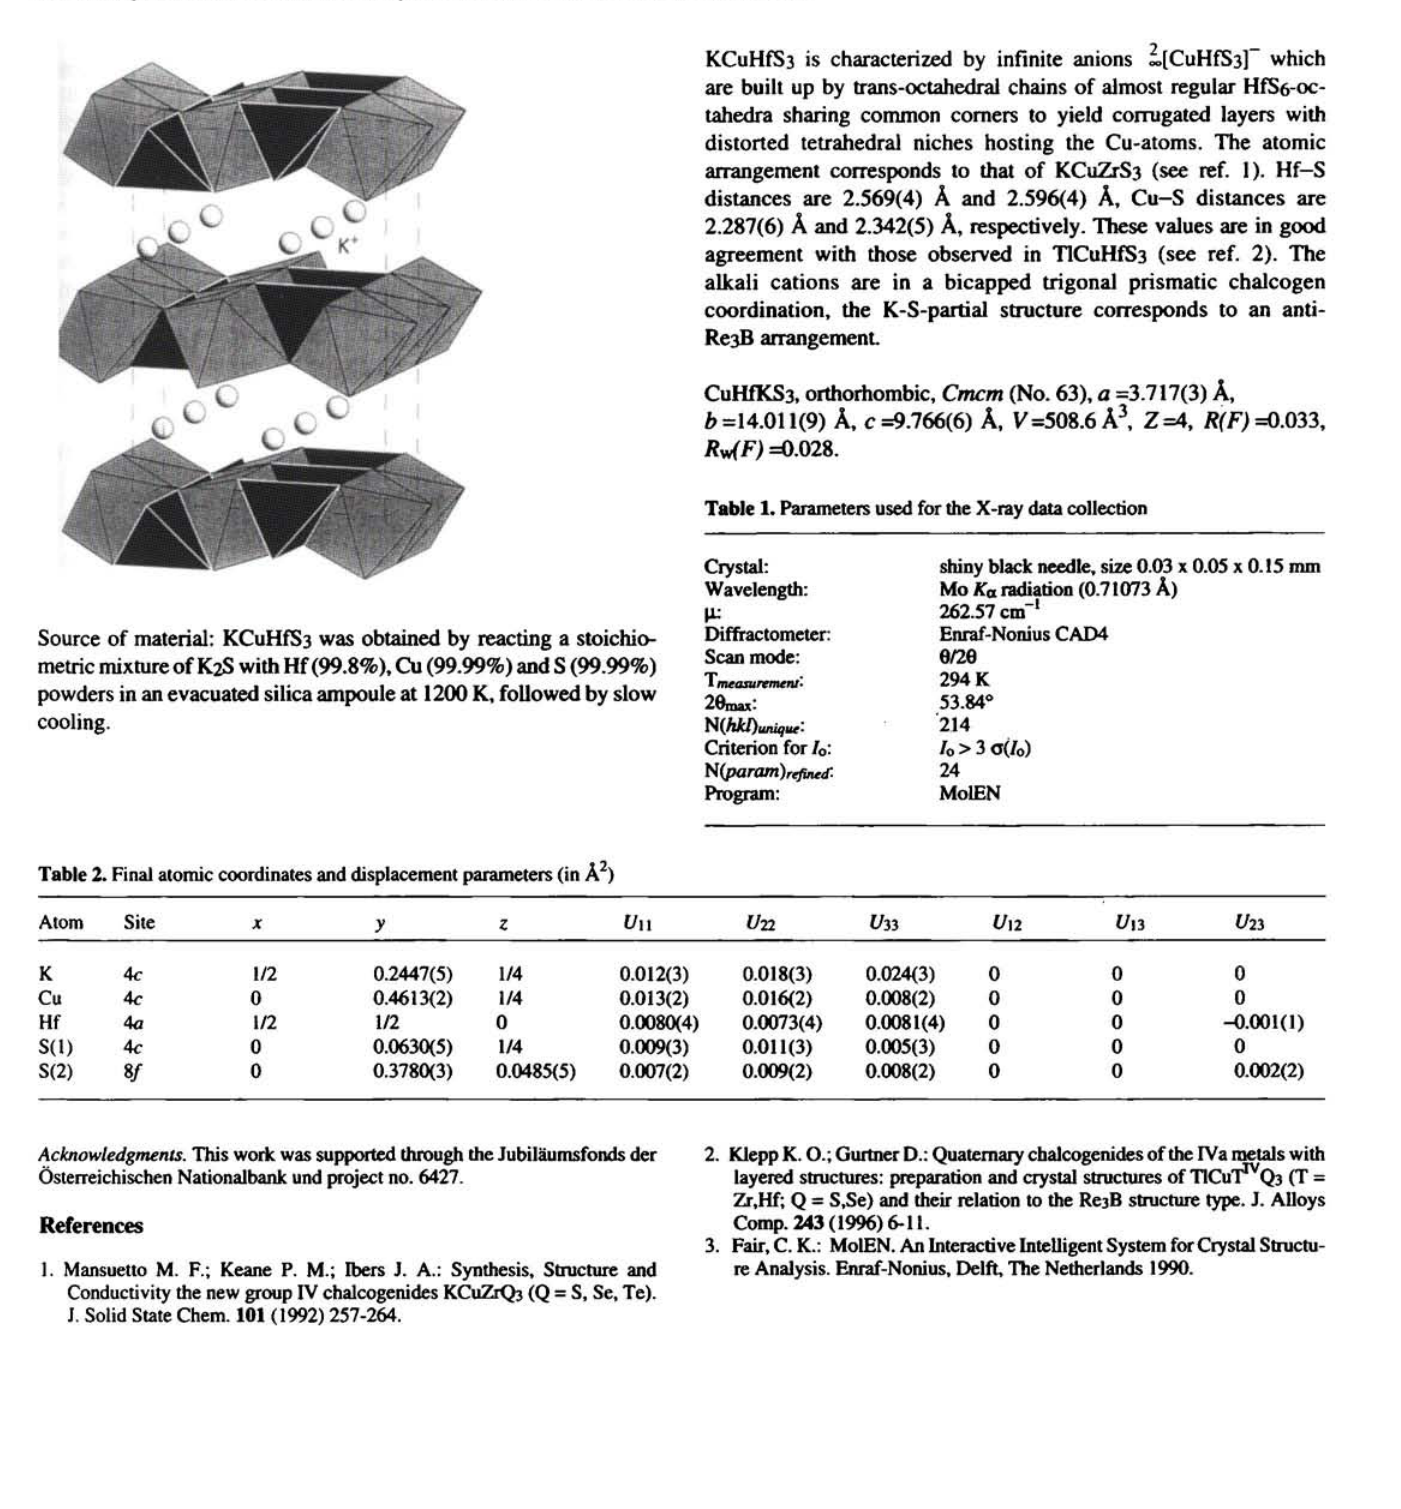
Table 2. Final atomic coordinates and displacement parameters (in